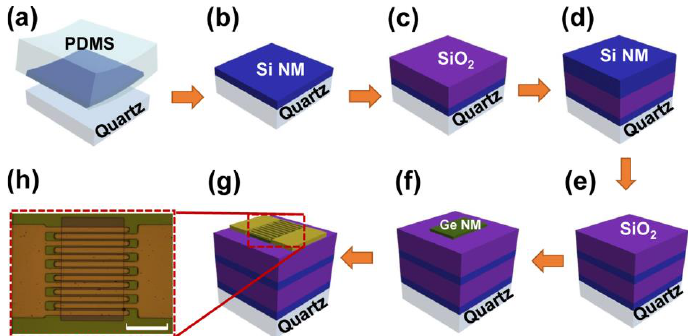
Figure 12. Schematic illustrations of the fabrication process for the resonant cavity (RC) metal-semiconductor-metal (MSM) Ge photodetectors. ( a ) Transfer Si NM with PDMS stamp.